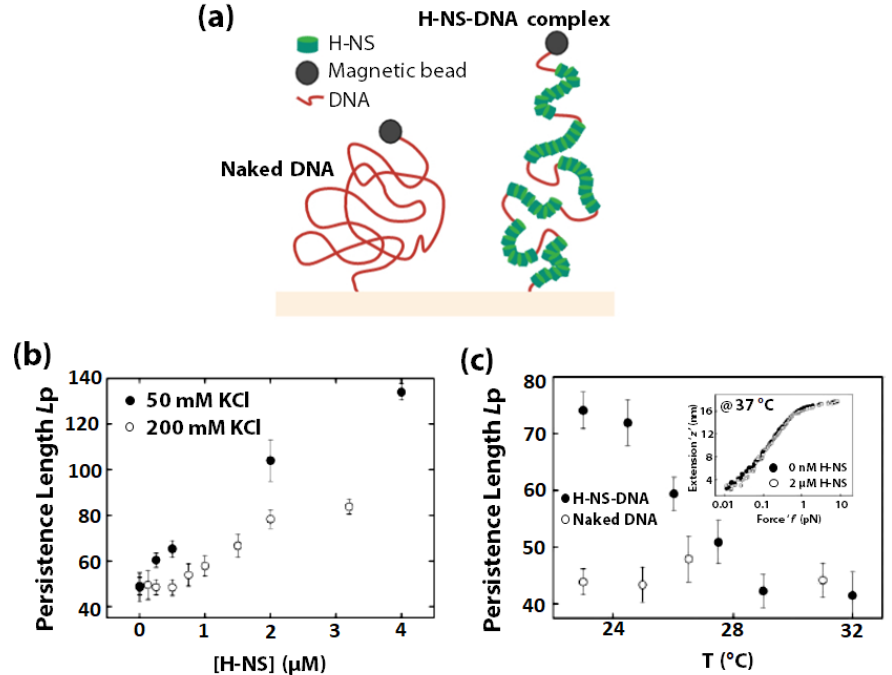
Figure 6. The effect of osmolarity and temperature on H-NS/DNA complex was investigated through force-extension experiments. ( a ) Schematic representation of the extended configuration of H-NS-λ-DNA complexes compares to that of naked λ-DNA in the low-tension regime (≤10 pN). The setup for measuring the end-to-end extension of DNA as a function of stretching force (magnetic force) is shown where DNA is tethered to a magnetic bead on end and a glass surface on the other. Change in persistence length (L p ) of ( b ) H-NS-DNA as a function of increasing H-NS concentration in the presence of 50 mM (solid circles) and 200 mM (open circles) KCl, ( c ) H-NS-DNA complexes (solid circles) and naked DNA (open circles) with increasing temperature. Inset: Extension ‘z’ in nm (y-axis) of single H-NS-DNA complexes as a function of force (f) in pN (x-axis) measured at 37 °C for 0 (solid circles) and 2 µM (open circles) H-NS. ( b , c ) adapted with permission from [179]. Copyright 2003, Biophysical Society.